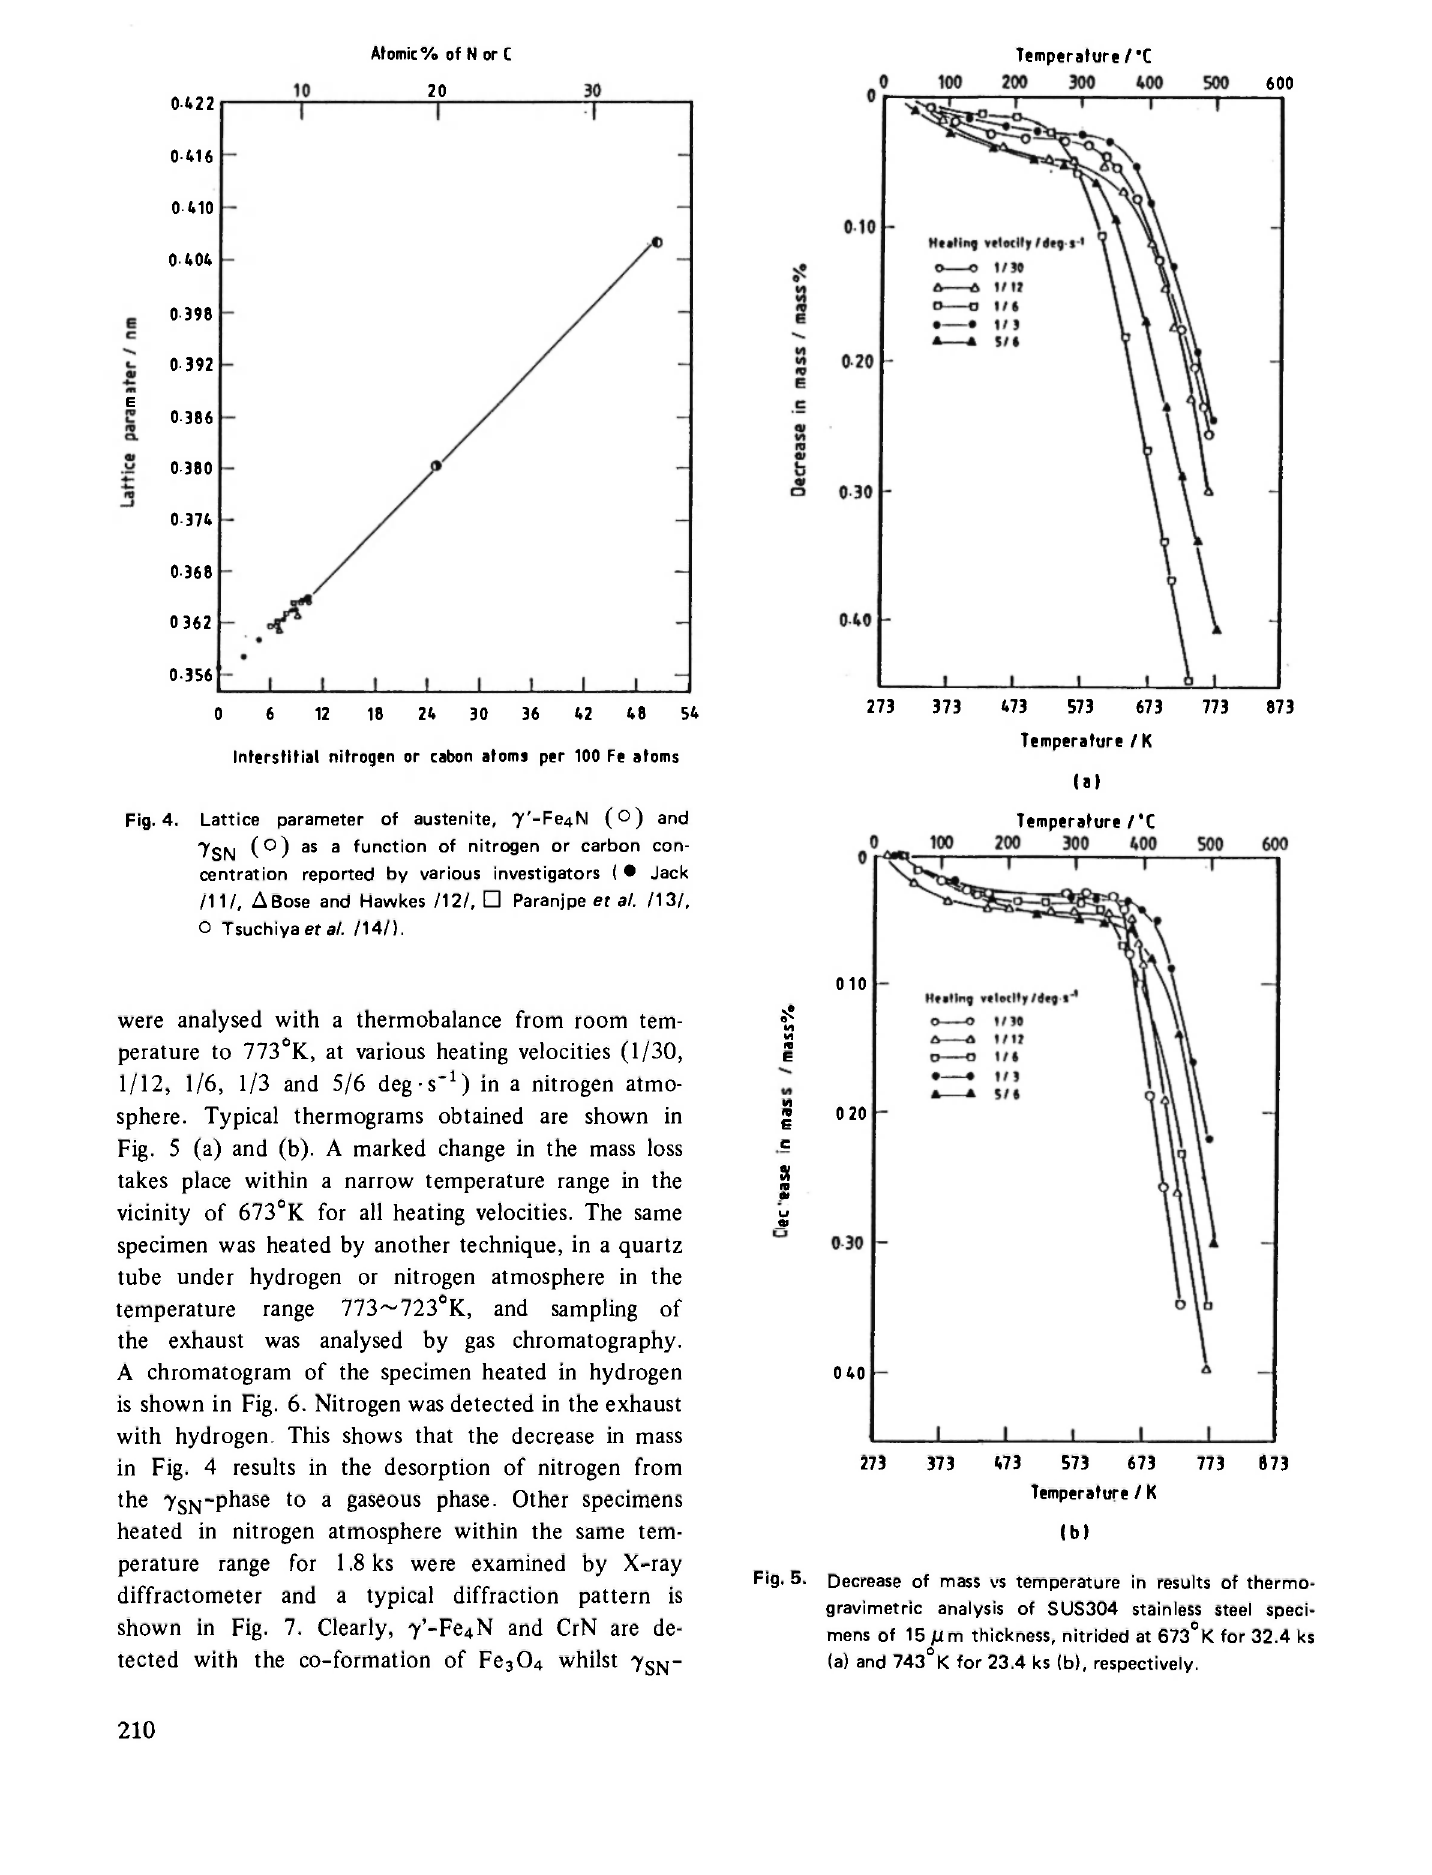
Fig. 5. Decrease of mass vs temperature in results of thermo- gravimetric analysis of SUS304 stainless steel speci- mens of 15 /im thickness, nitrided at 673°Κ for 32.4 ks (a) and 743°K for 23.4 ks (b),